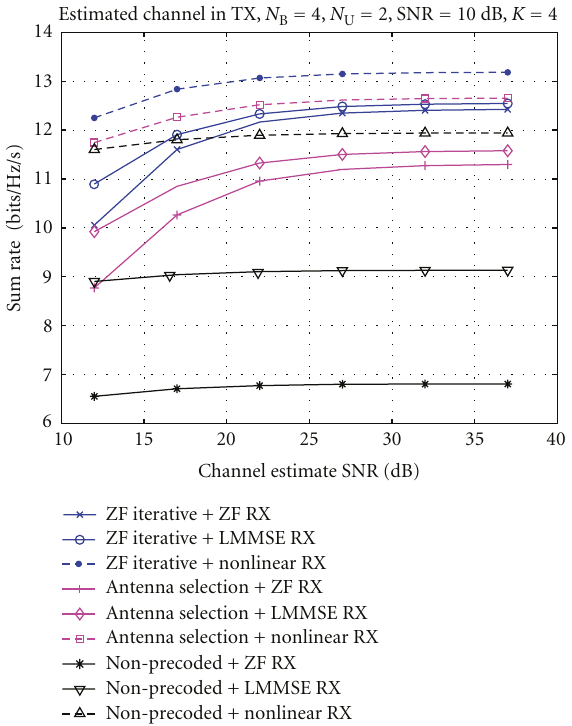
Figure 9: Uplink average sum rate, with noisy CSIT and di ff erent receivers, N B = 4, N U = 2, K = 4, D S =